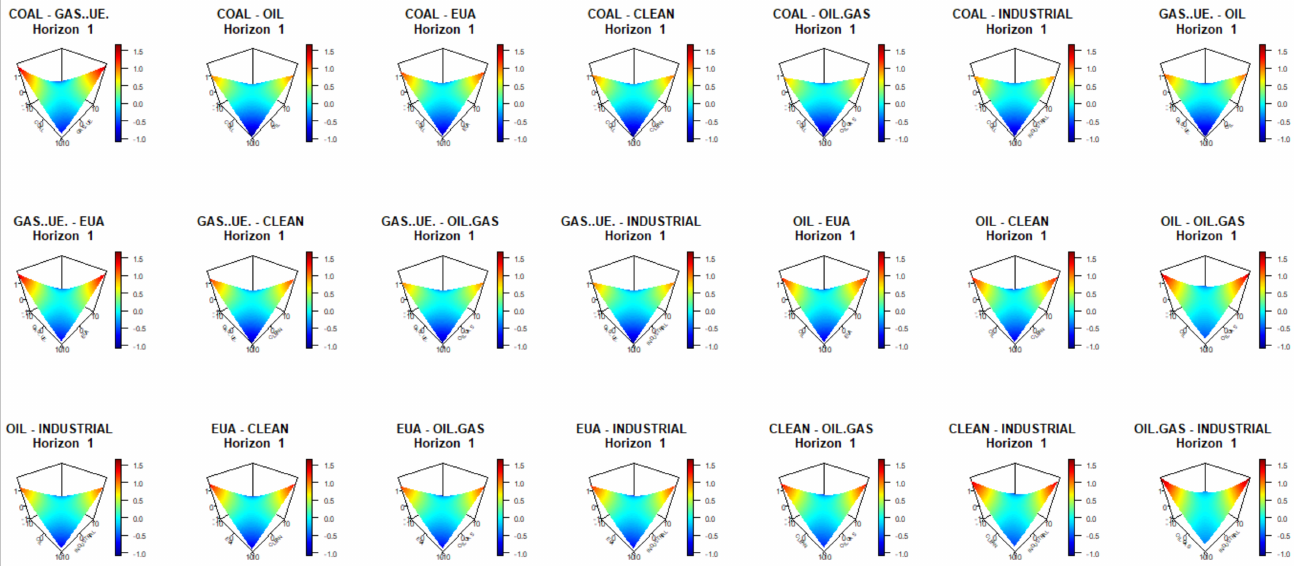
Figure 14. Matrix graph with the response surfaces of the conditional correlation between all pairs of combinations of two variables to bivariate impulses on